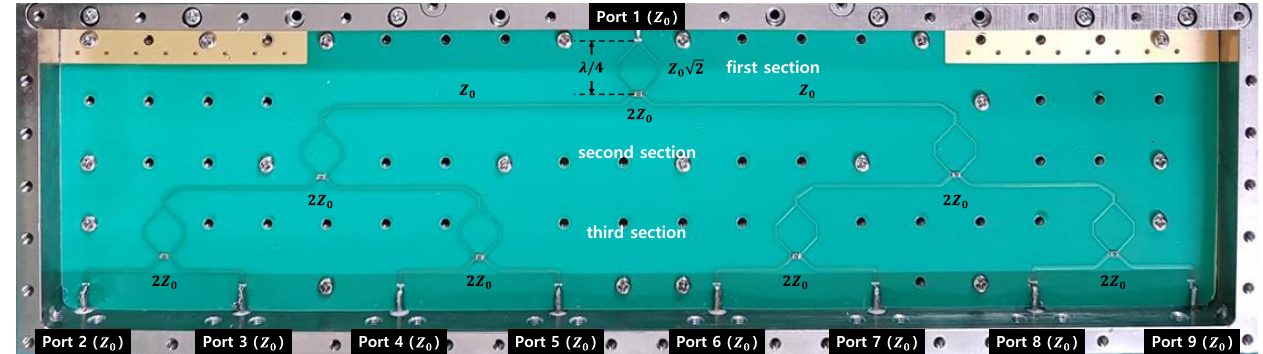
Figure 7. Photograph of the power dividing part using Wilkinson divider.